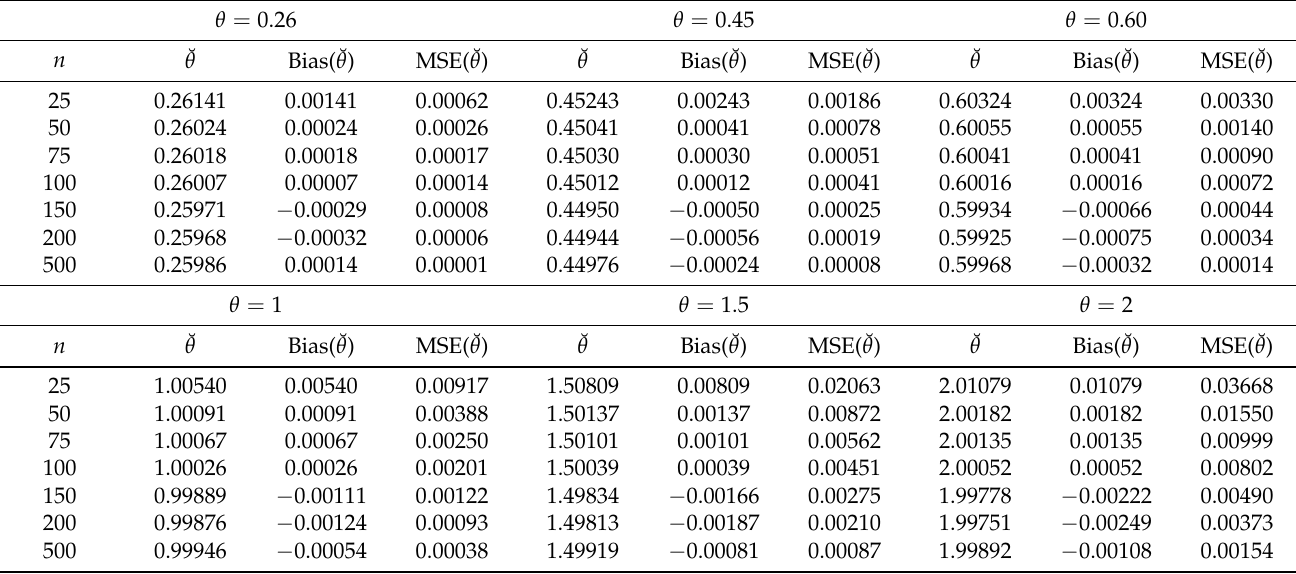
Table 3. Simulation results: WLS estimates, bias, and